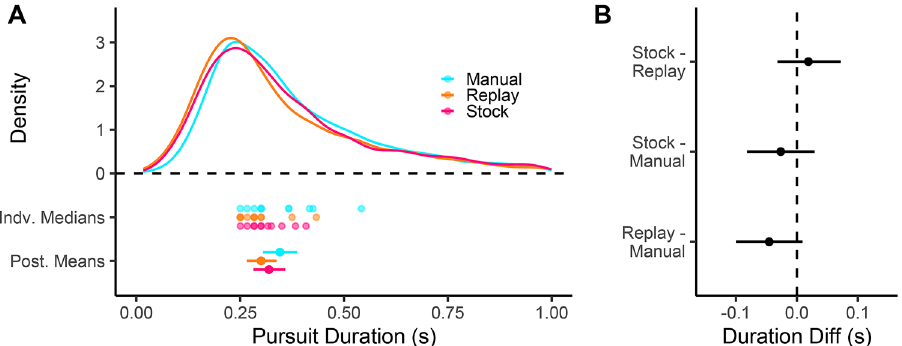
Figure 11. Gaze tracking duration. ( A ) The distribution of pooled gaze tracking duration, of Manual (cyan), Auto-Replay (orange) and Auto-Stock (magenta) conditions. Shown below are the participant medians, and the posterior estimates of the mean of medians. ( B ) The posterior estimates of the mean difference between conditions, with 95% HDIs